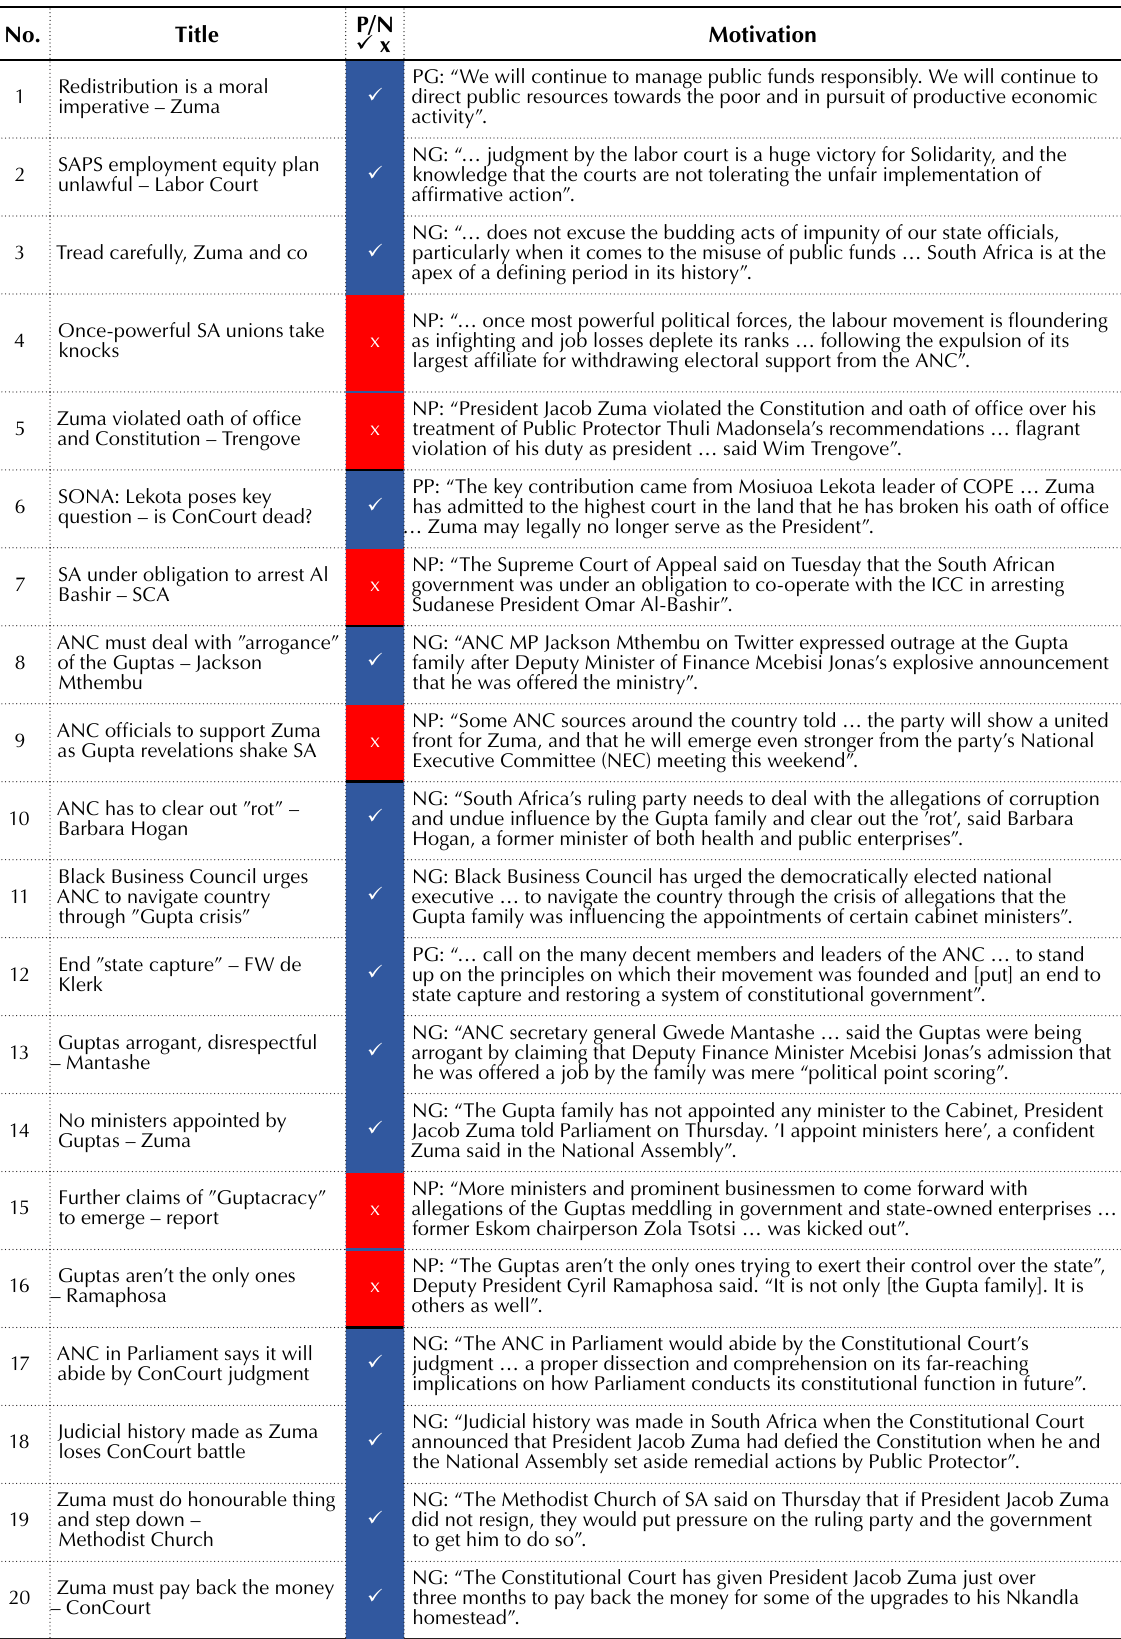
Table 5A. Institutional macro-environment (January-June